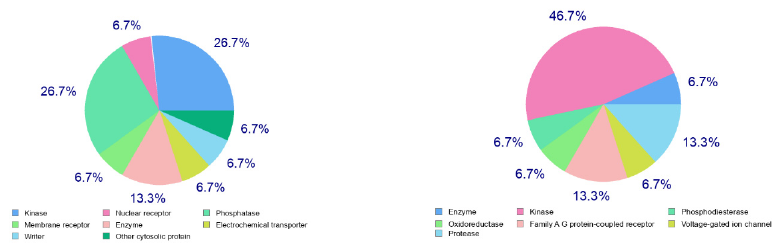
Figure 10. Bioavailability radars of 3 ( left ) and 4 ( right ).